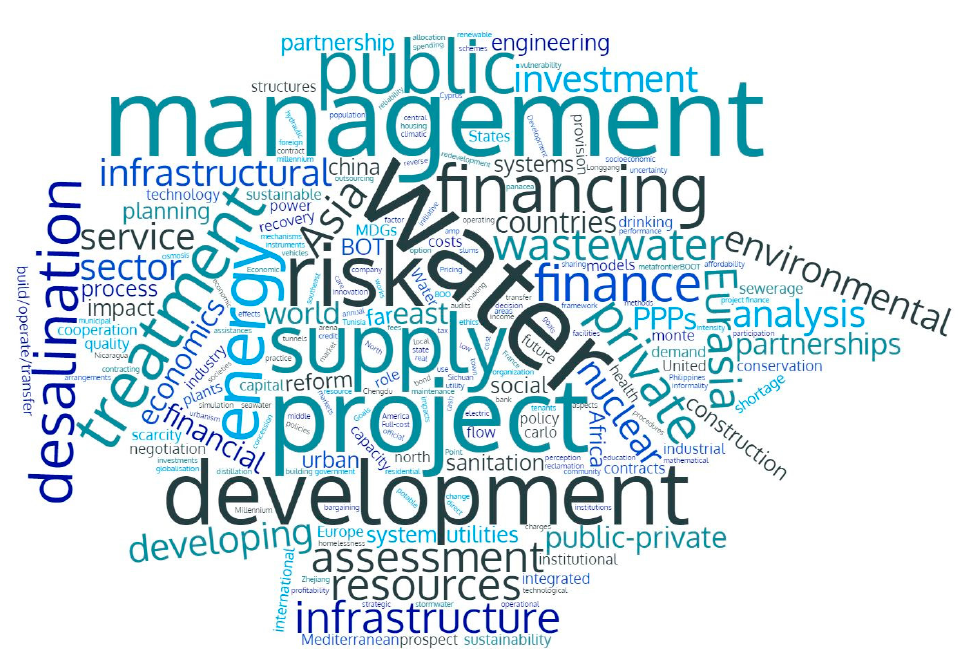
Figure A4. Research topics’ word cloud—2000s.